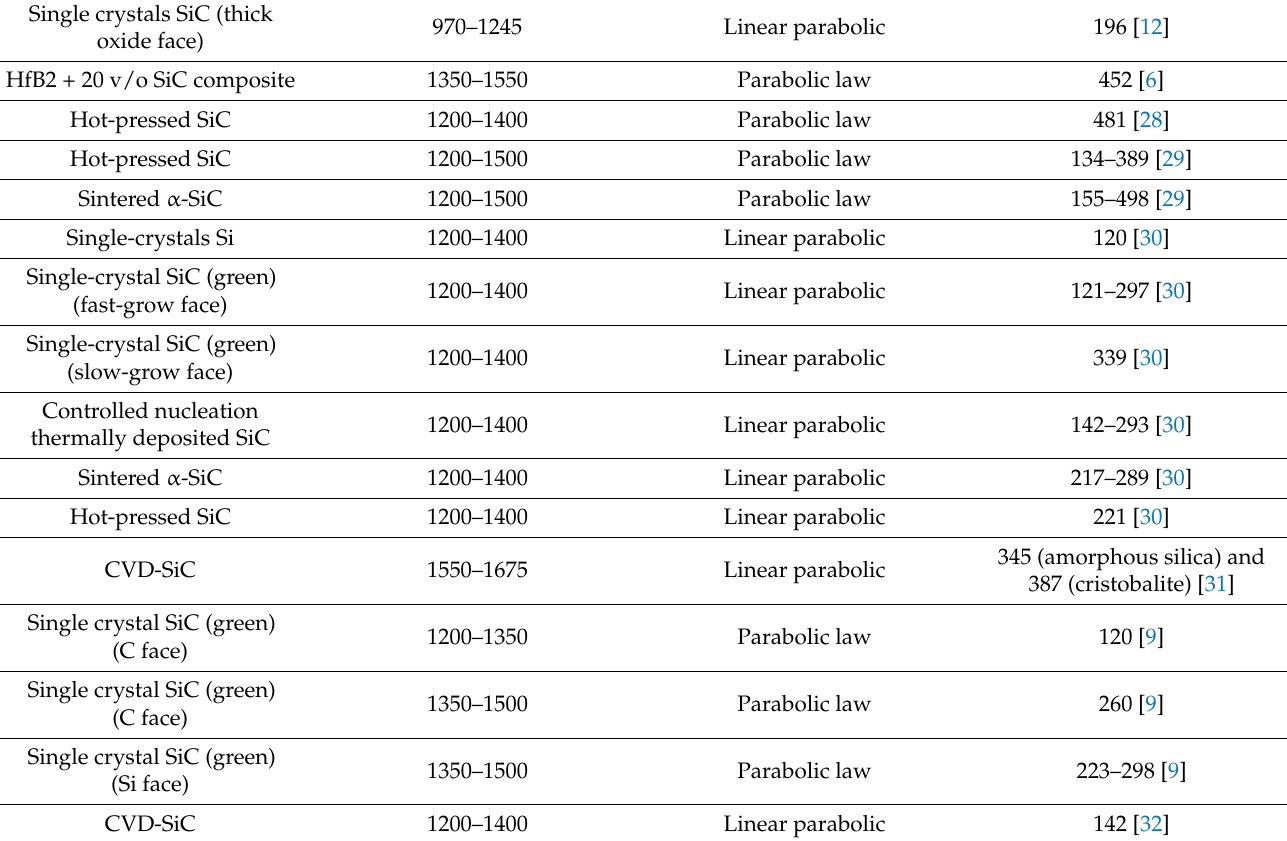
Table 2. Activation energies for parabolic oxidation of SiC in dry